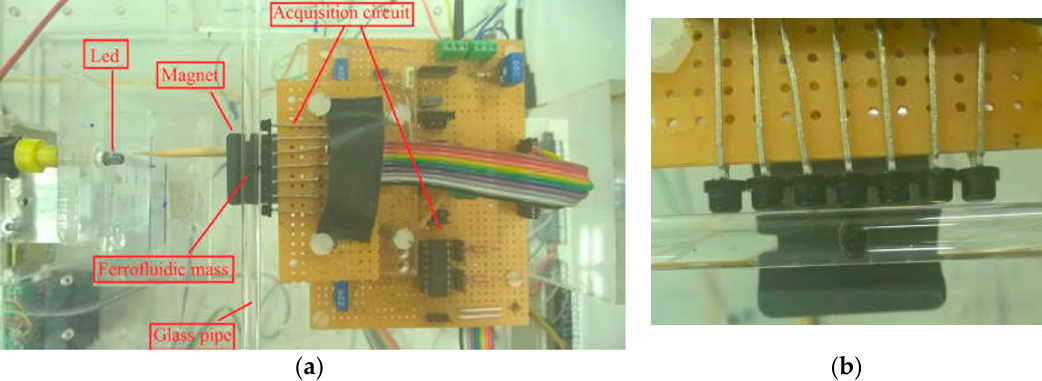
Figure 1. Real view of the Optical Ferrofluidic Inclinometer. ( a ) The whole system; ( b ) a detail of the IR readout strategy and the ferrofluid